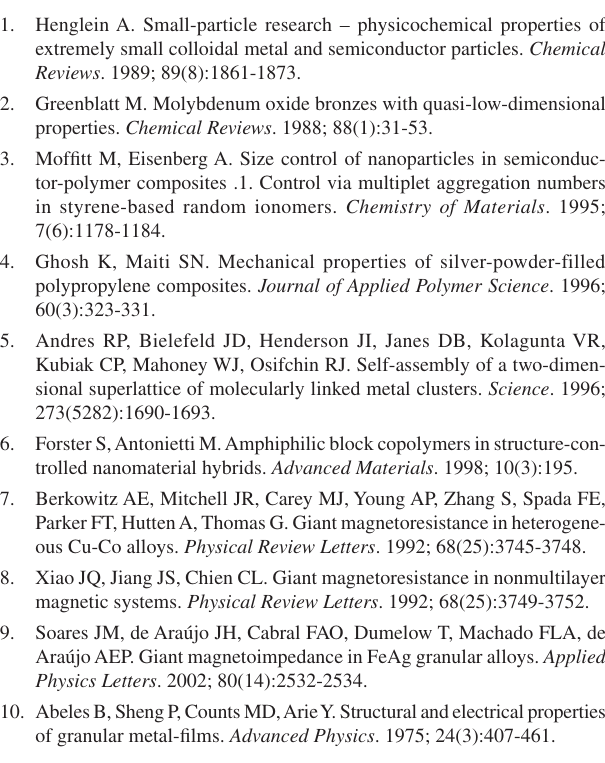
Ag prepared at different annealing 10 90